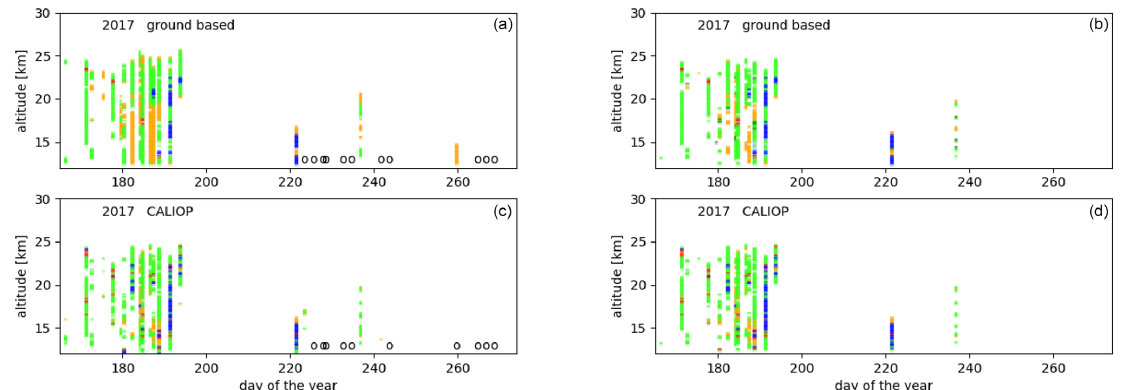
Figure 6. All quasi-coincident observations (a, c) and only those where PSCs were observed by both lidars (b, d) for 2017 above Dome C. (a, b) Ground-based lidar. (c, d) CALIOP above Dome C. The different colors indicate PSCs of different composition. Green: NAT mixtures; yellow: STS; red: enhanced NAT mixtures; blue: ice. The circles indicate measured profiles without PSCs.